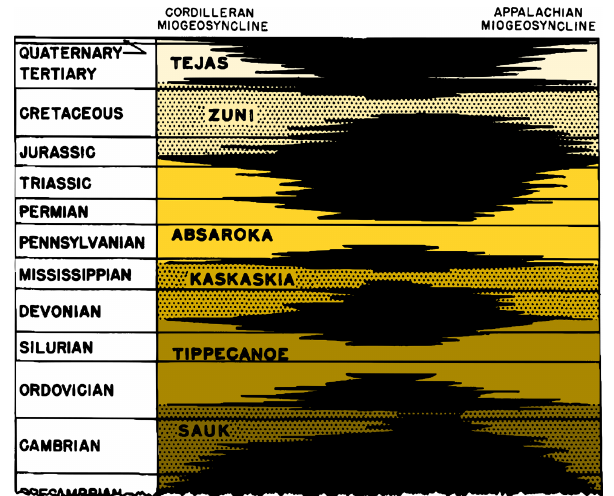
Figure 23. Sequences of the North American craton (modified from Sloss, 1963). The black areas represent temporal gaps, and the light areas represent the depositional